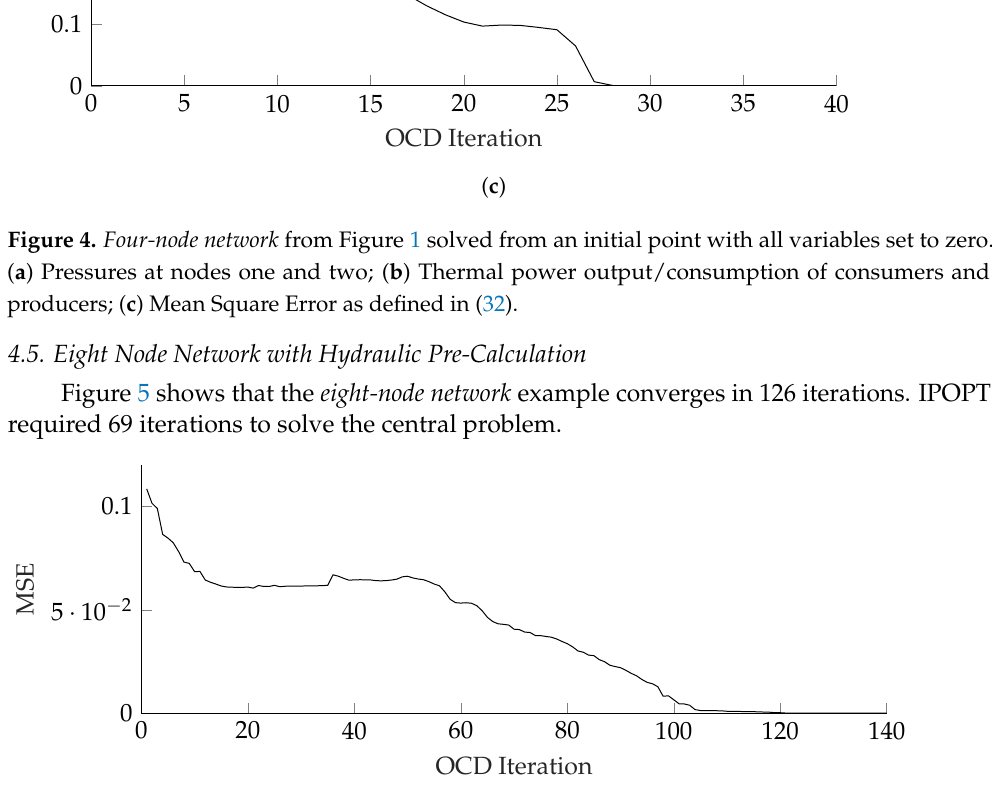
Figure 5. MSE while solving the eight-node network from Figure 2 using initialization based on hydraulic